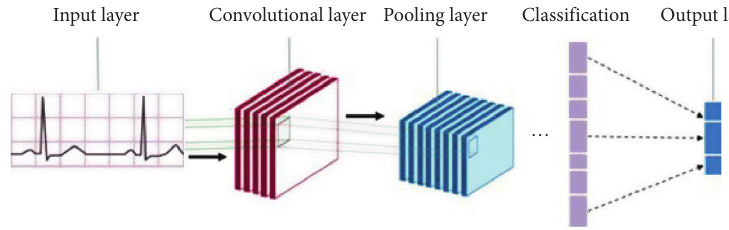
Figure 7: Structure of a forward-pass CNN.